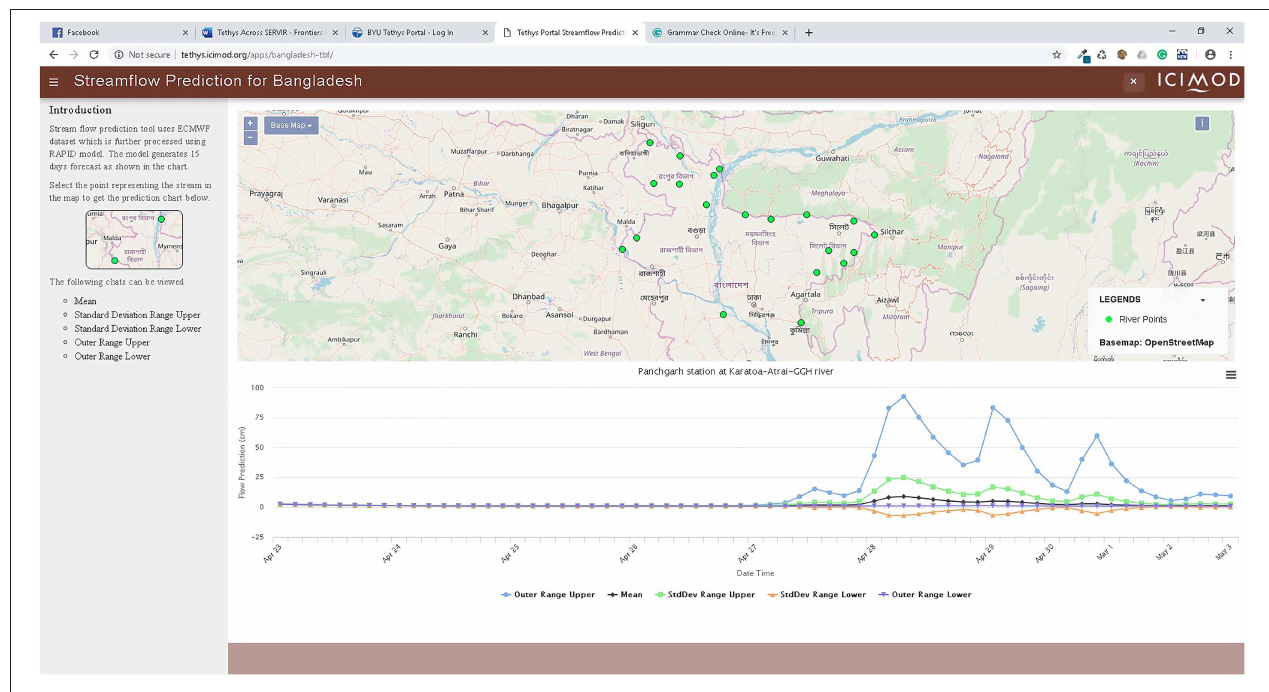
FIGURE 8 | Bangladesh transboundary flows Tethys application.